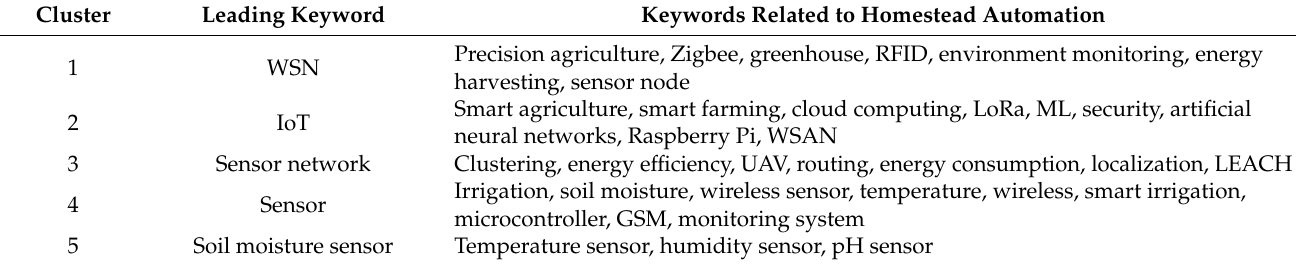
Table 1. Keywords co-occurrence clusters, based on